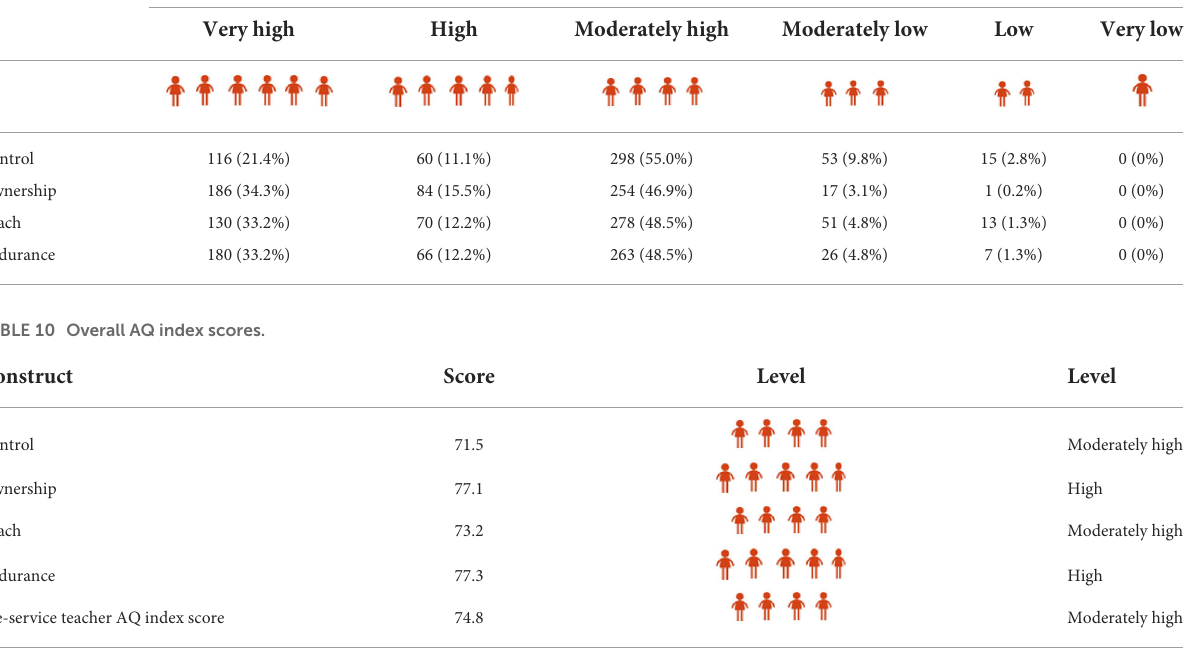
TABLE 9 Crosstab between AQ levels and constructs ( n = 542).